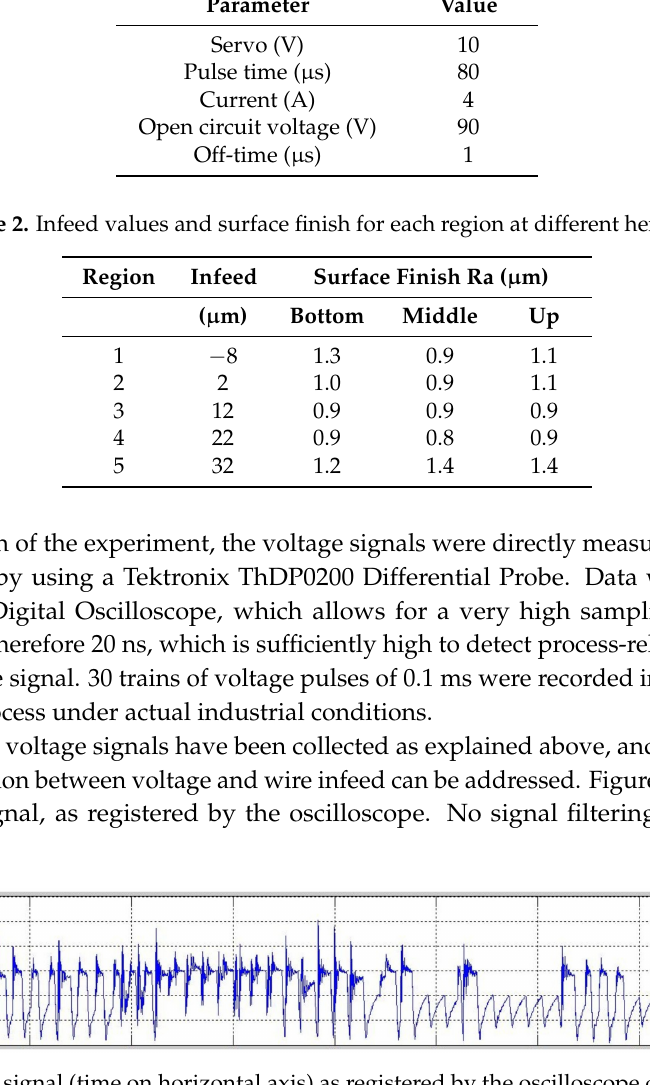
Figure 2. Voltage signal (time on horizontal axis) as registered by the oscilloscope during the second trim